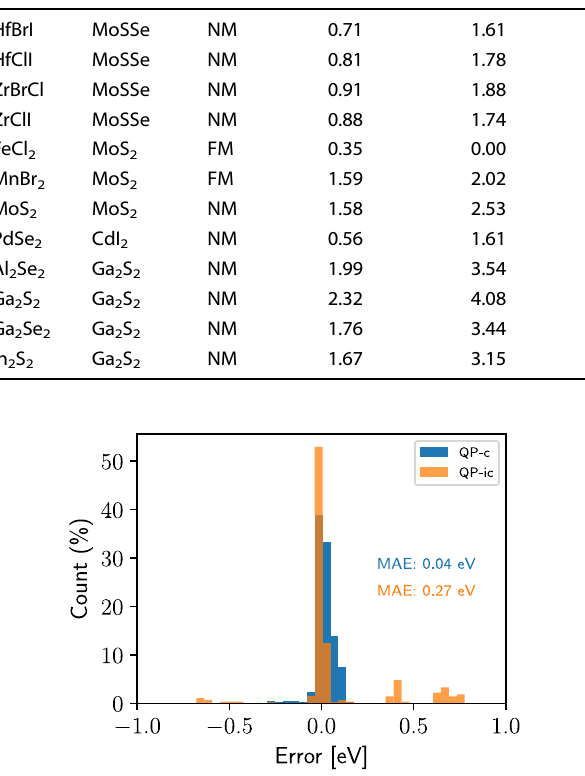
Fig. 5 Errors of quasiparticle-consistent and -inconsistent solu- tions. The distributions of the error incurred by the linear approximation as estimated from 3192 states in 12 different materials for which we have calculated the full frequency- dependent self-energy and determined the exact QP energy (see main text). The distribution for QP-c states is shown in blue, while the distribution for QP-ic states is shown in orange. The inset shows the full distribution for QP-ic